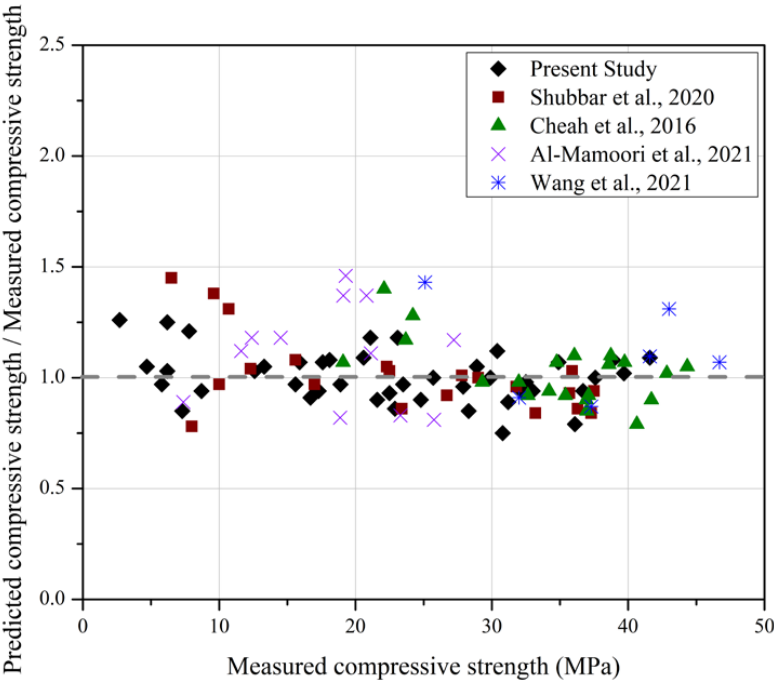
Figure 8. Calculated compressive strength values-to-measured compressive strength values ratio using the proposed multivariable strength prediction model—Equation (3b) [38–41].